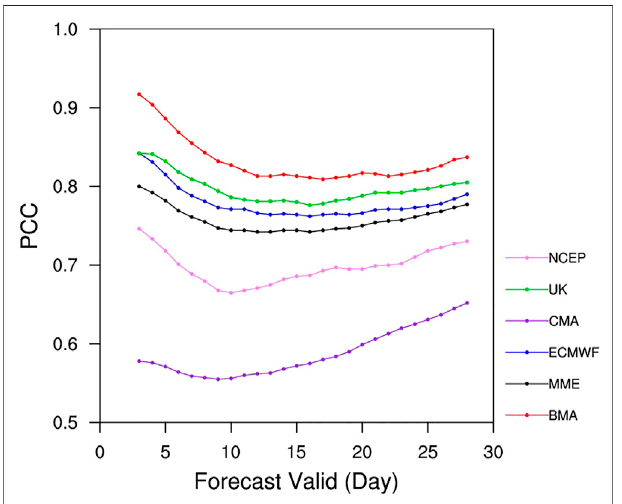
FIGURE10| The BSforheatwave asafunctionofforecast leaddays for different reforecasts including SMEs, MME, and BMA.